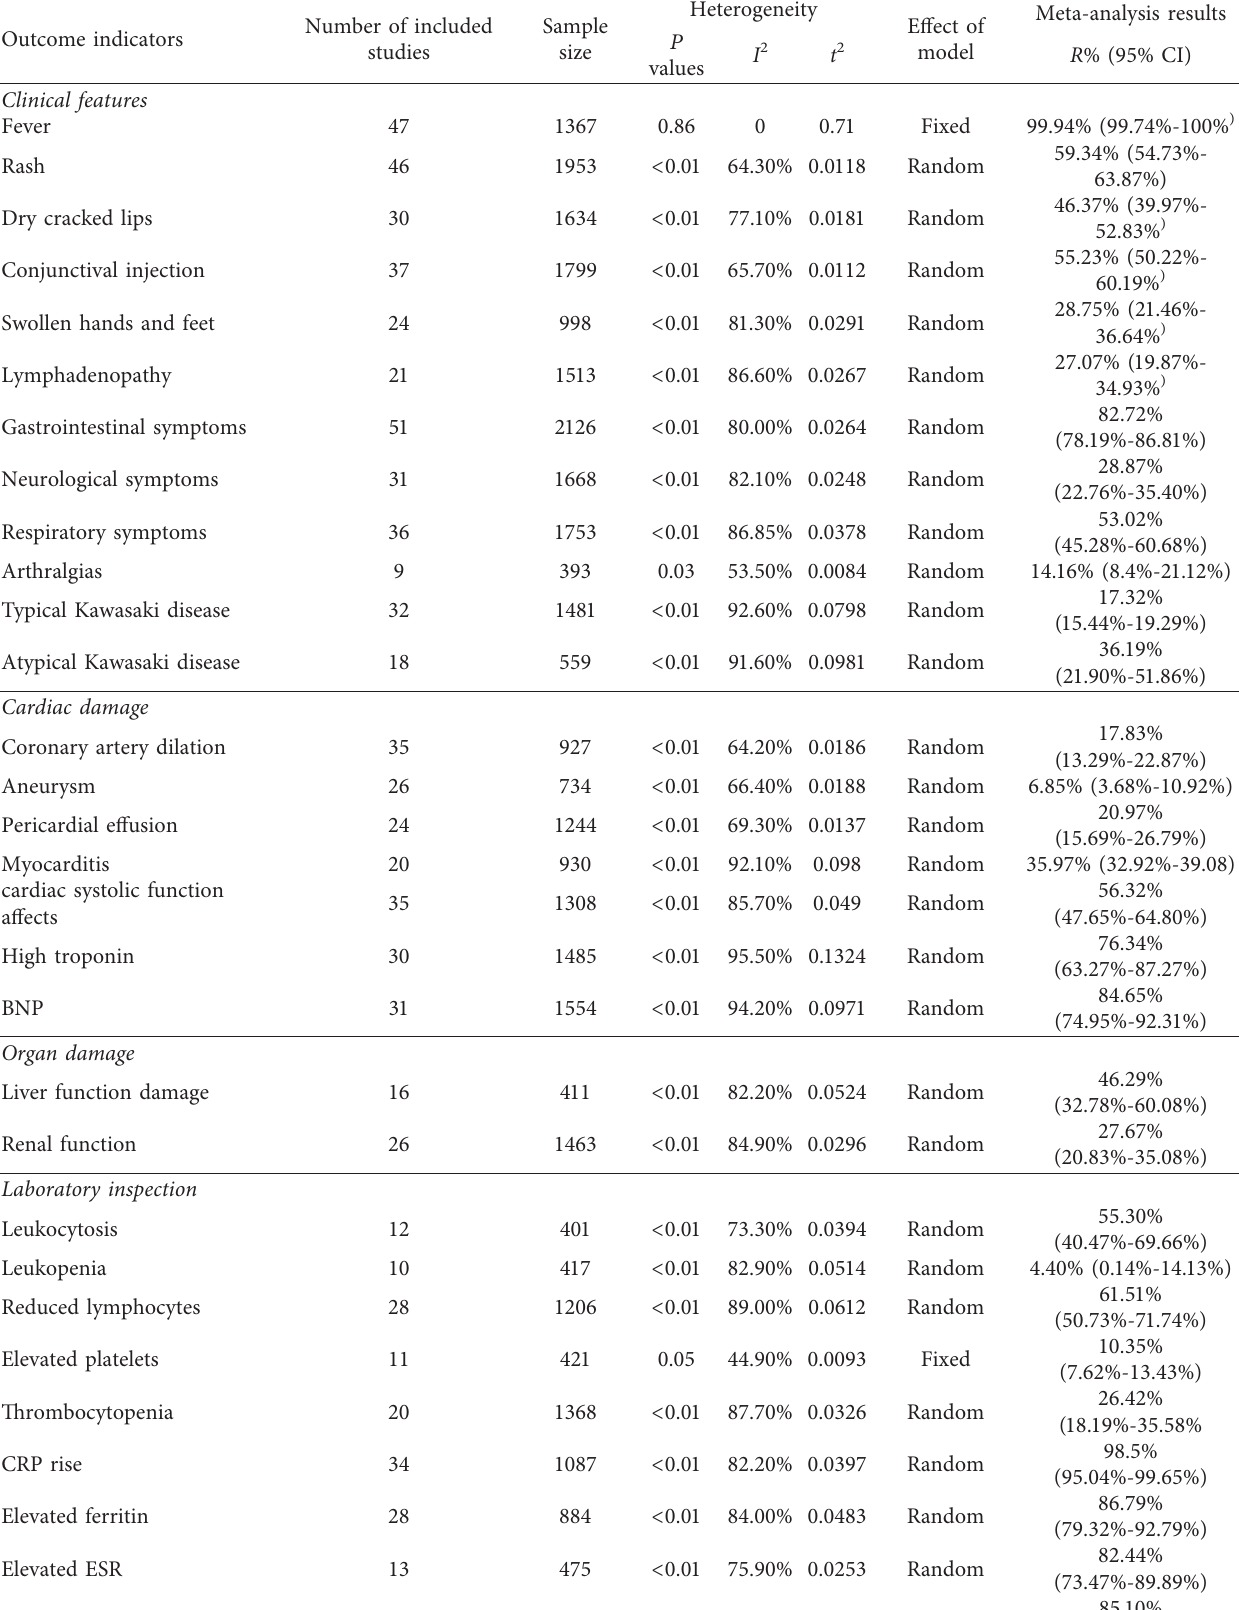
Table 1: Meta-analysis